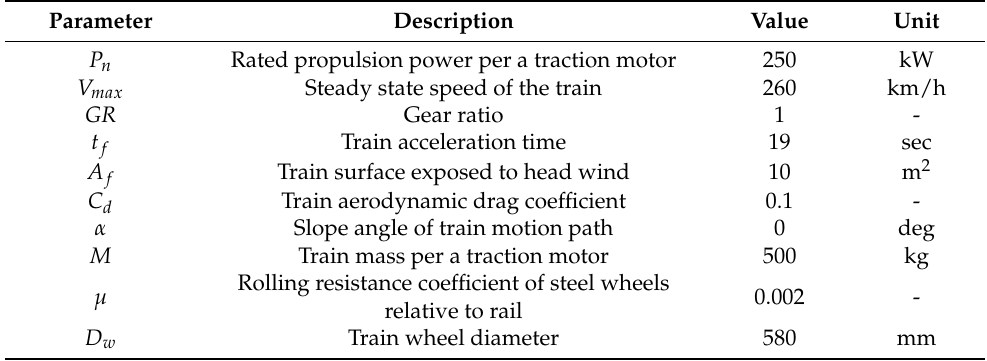
Table 1. Train motion